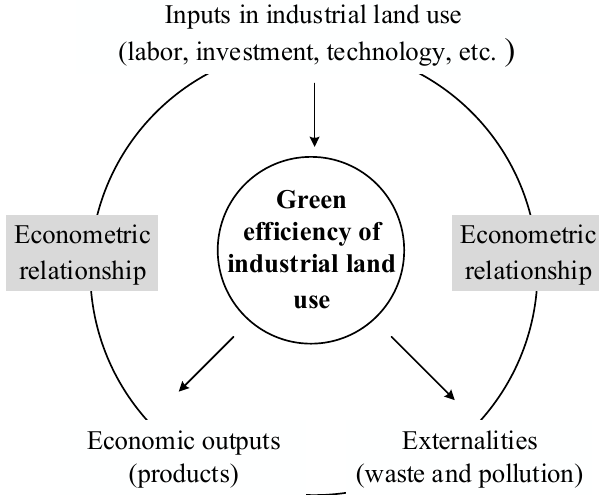
Figure 1. Formation of the green efficiency of industrial land use.